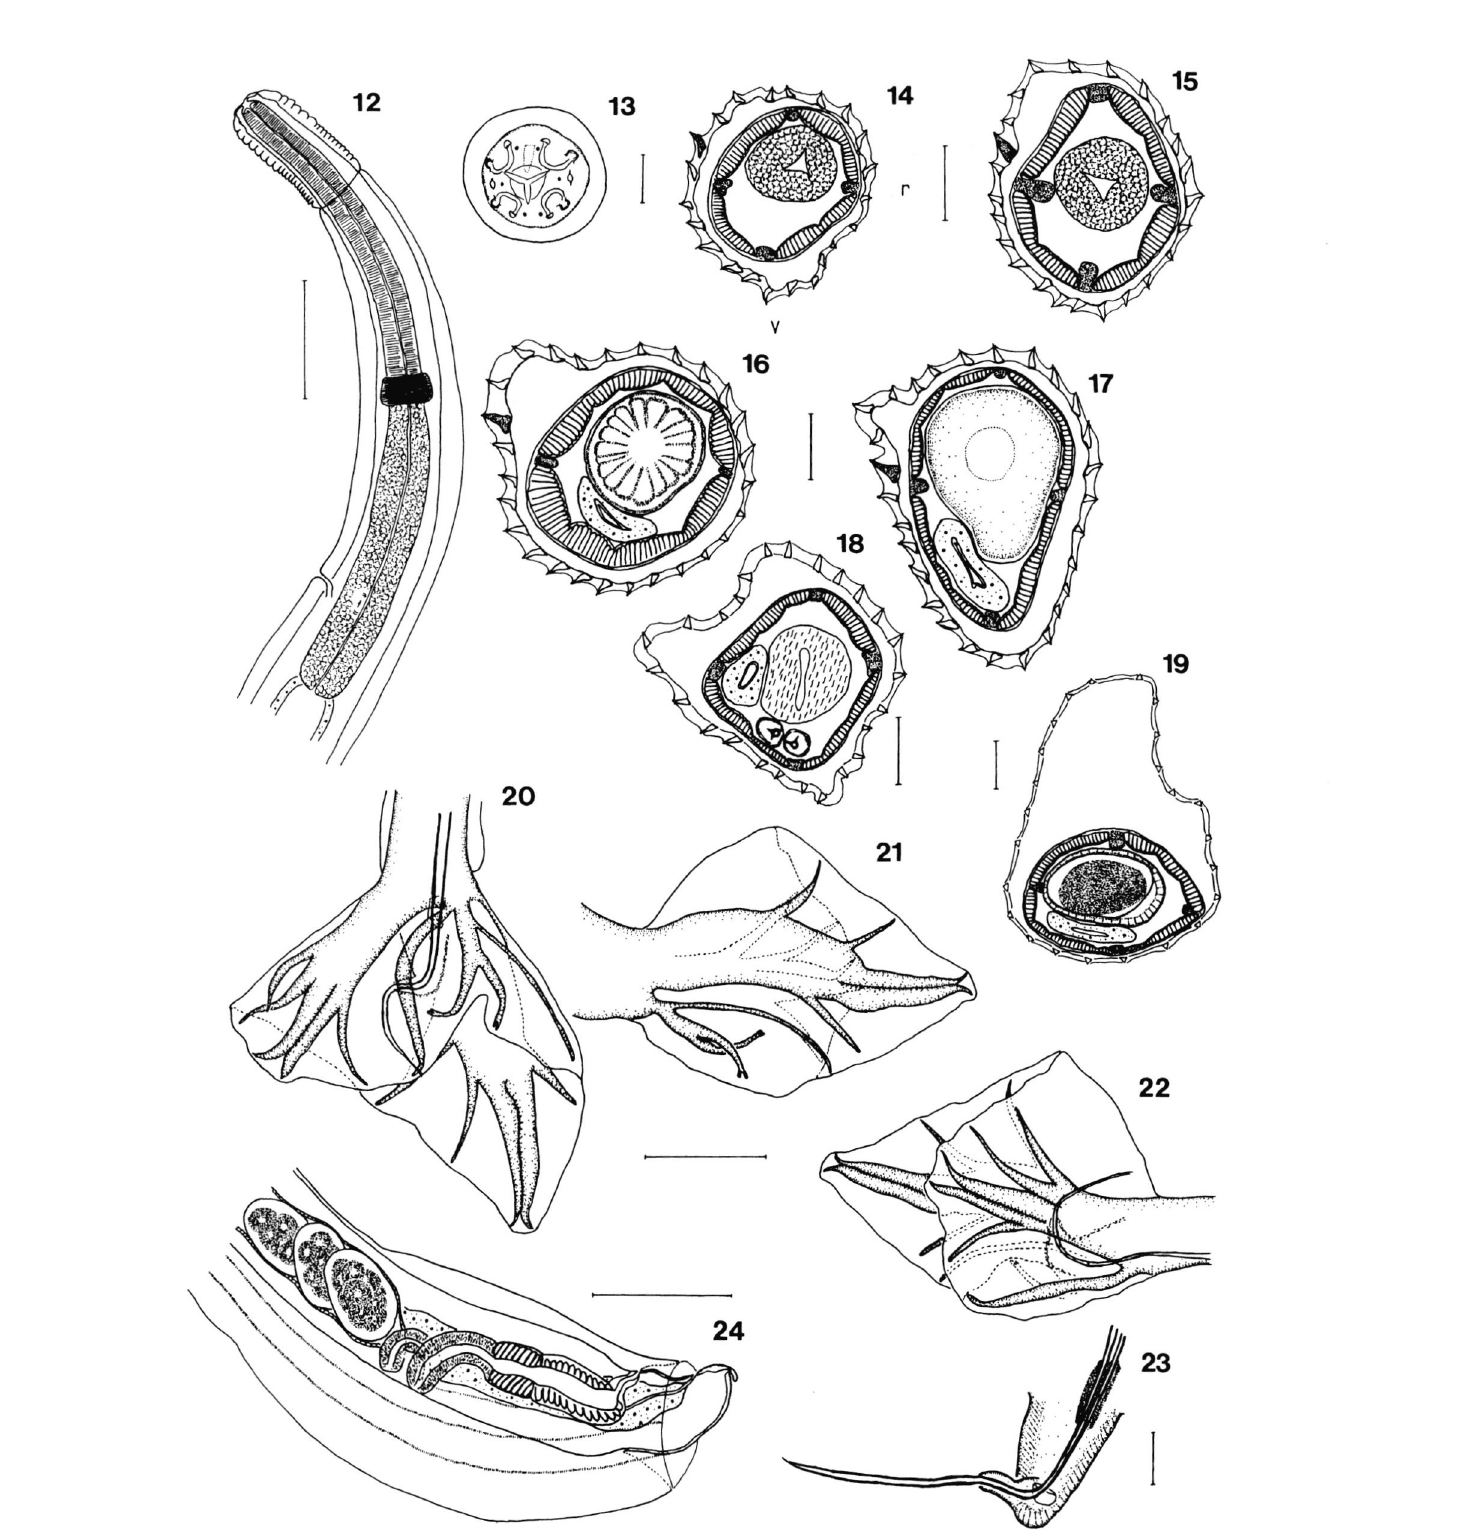
Figs 12-24. - Stilestrongylus franciscanus n. sp. from Graomys griseoflavus. 12, male, anterior extremity, left lateral view. 13. female, head, apical view. 14-17, transverse sections of body (largest ridge shaded): 1 i- 15, at oesophago-intestinal junction. 14, male. 15. female: 16-17. at mid-body. 16. male, 17, female; 18-19, at posterior end, 18, male, 180 µm anterior to caudal bursa, 19. female, distal part of uterus, at 320 µm from posterior end. 20-22, male, caudal bursa, 20, latero-dorsal view, 21, right lobe, latero-dorsal view (left lobe in dotted lines), 22, left lobe, latero-dorsal view (right lobe and genital cone in dotted lines). 23, genital cone, ventro-lateral view. 24, female, posterior extremity, right lateral view. Abbreviations: r. right, v. ventral. Scale bars: 12, 50 µm; 13. 10 µm; 14-19, 23, 20 µm; 20-22, 24, 100 µm.